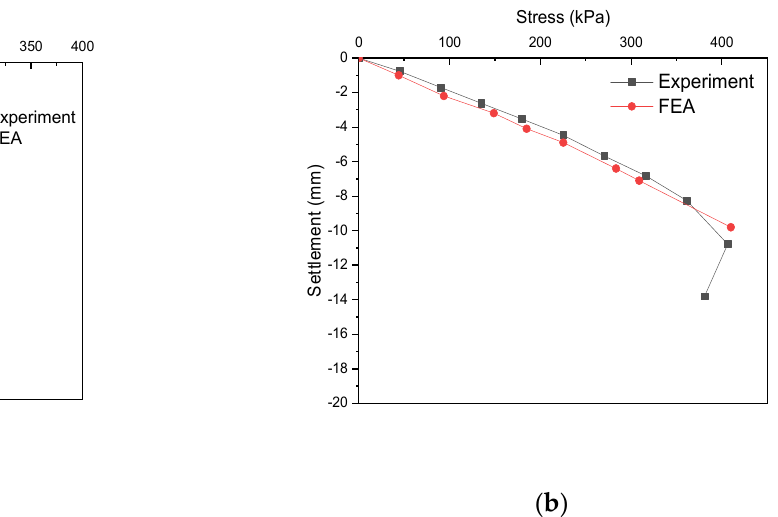
Figure 2. Comparison of load–displacement for the experimental work and the numerical simulation results for ( a ) unreinforced sections and ( b ) reinforced sections.